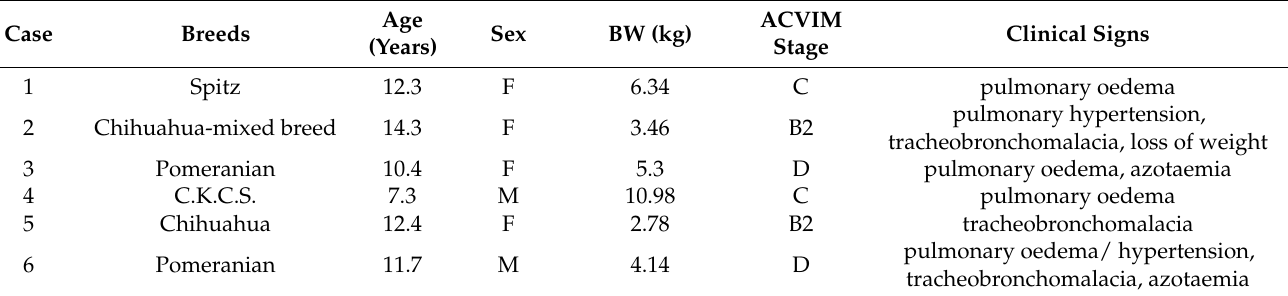
Table 1. Signalment, ACVIM stage, and clinical signs of 6